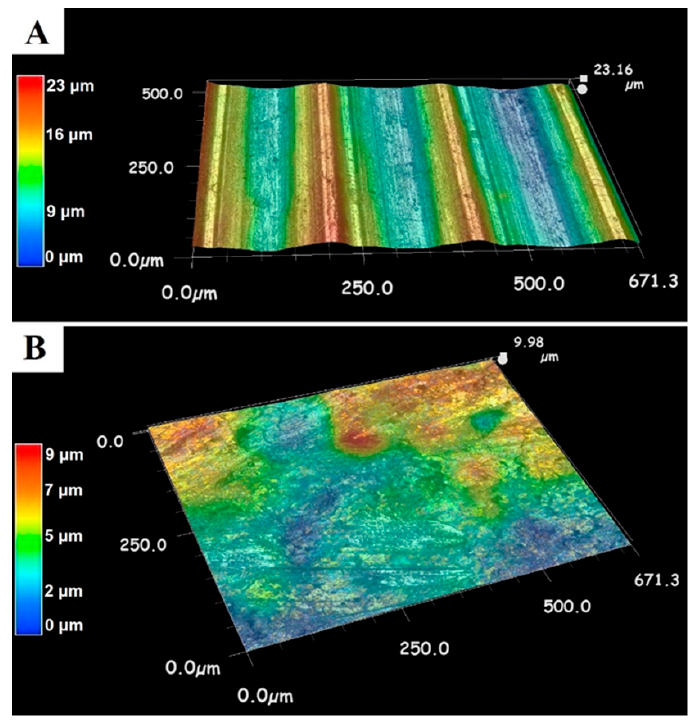
Figure 1. LM images of the piece of the truck wheel hub (AL1), the cast and machined surface ( A ), the cast and forged surface ( B ).